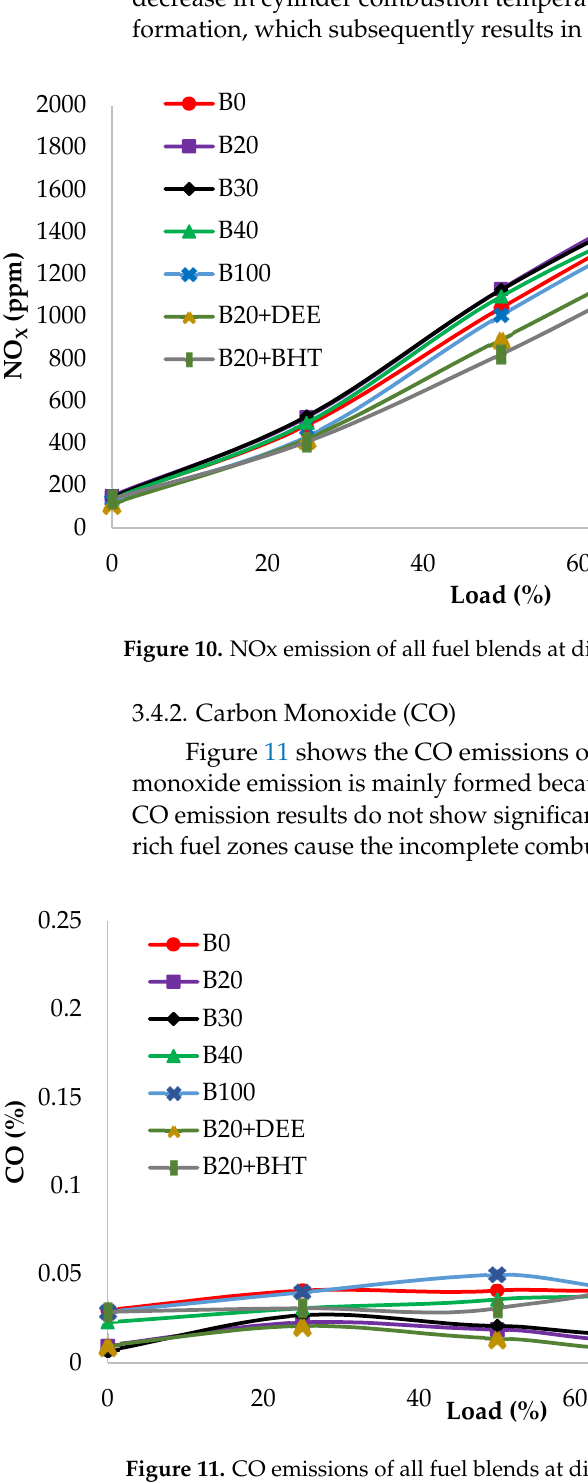
Figure 9. BSFC of all fuel blends at different engine loads.